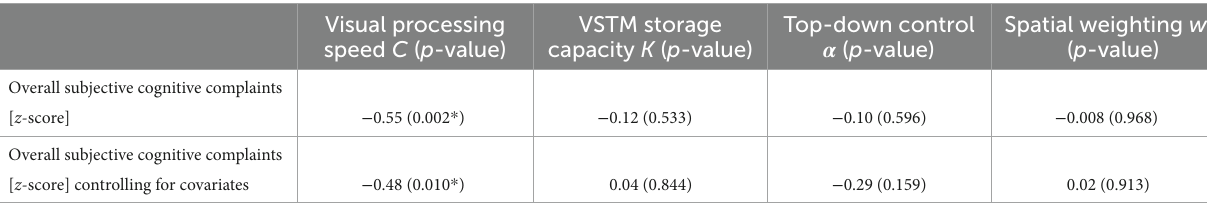
TABLE 4 Correlation of TVA parameters with subjective cognitive complaints with and without controlling for age, education, and depressive symptoms.